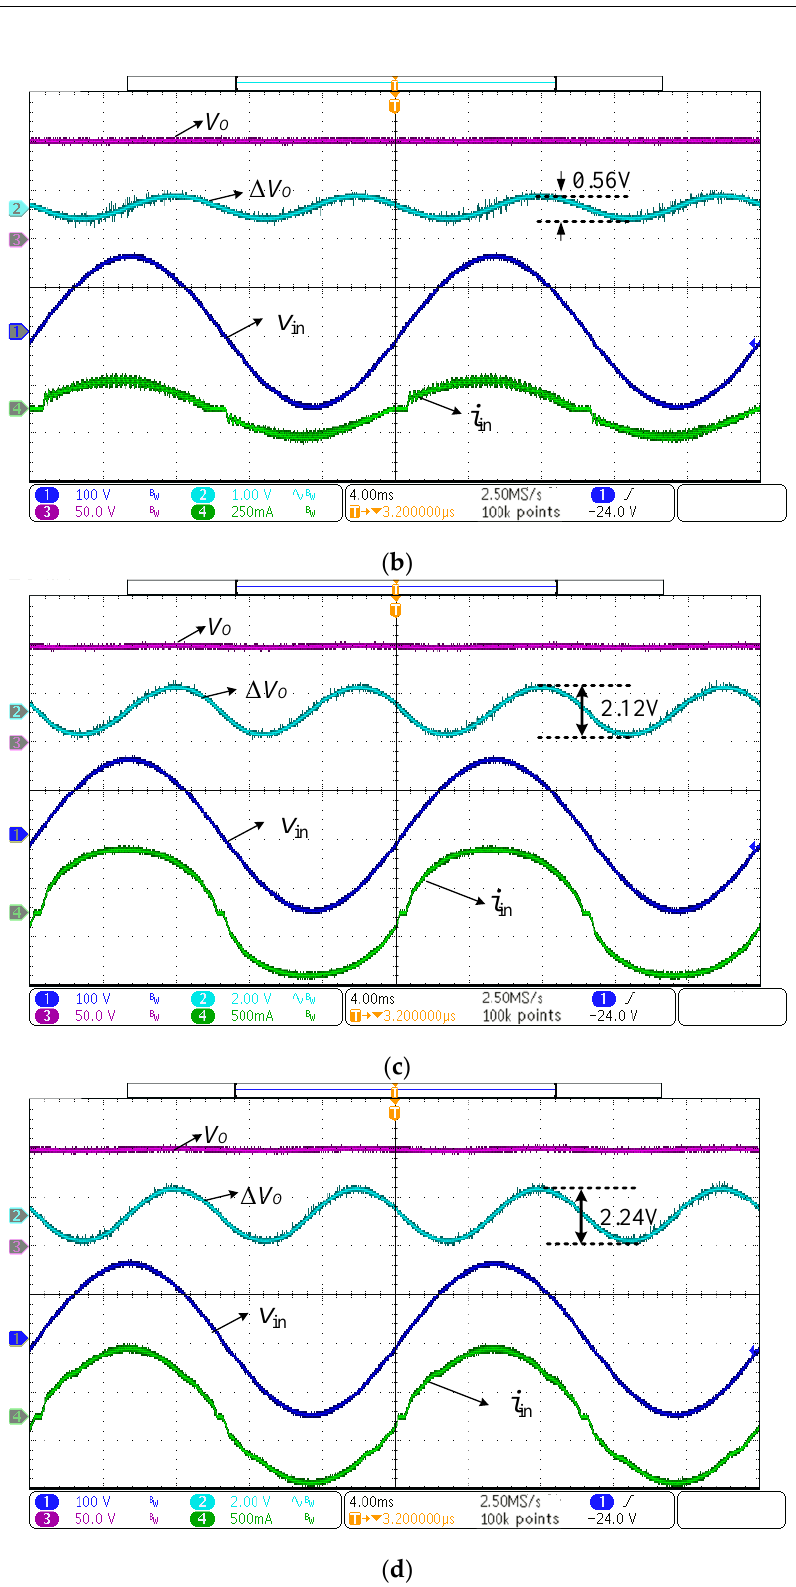
Figure 19. Experimental waveforms of Δ V O , V O , v in , and i in with 110 Vac input voltage, 0.1 A and 0.5 A output current. ( a ) COT with 0.1 A output current; ( b ) VOT with 0.5 A output current; ( c ) COT with 0.5 A output current; ( d ) VOT with 0.5 A output current.